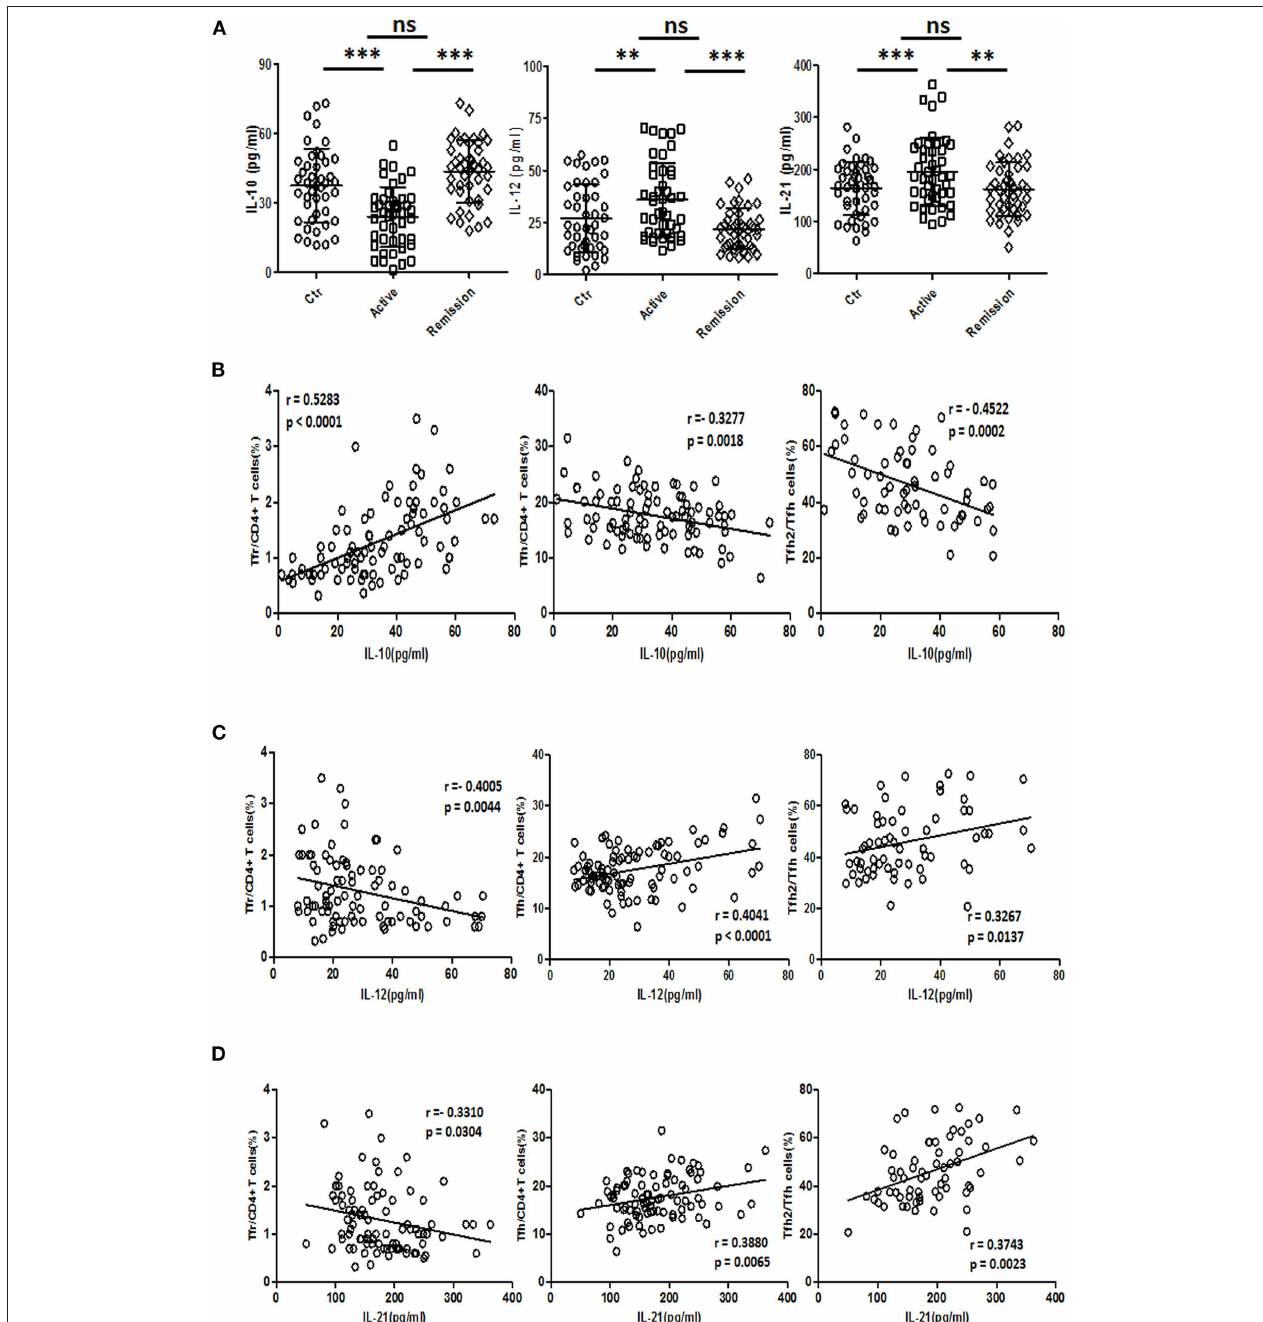
FIGURE 7 | Serum IL-10, IL-12, and IL-21 analysis and their relationship with TFR and TFH. (A) IL-10, IL-12, and IL-21 levels in serum of 44 healthy controls, 44 UC patients in active stage and 44 UC patients in stable remission were analyzed by ELISA. Their levels among three groups were compared. Symbols represent individual subjects and bars show the mean ± SD. ** p < 0.01; *** p < 0.001; ns, not significant. (B–D) Correlation analysis between serum IL-10, IL-12, IL-21 concentrations, and percentages of CXCR5 + FoxP3 + TFR cells, CXCR5 + FoxP3 − TFH cells was performed among 88 UC patients, including 44 active and 44 stable remission UC patients. Correlation analysis between cytokine levels and CXCR3 − CCR6 − TFH2 subsets was conducted in 64 UC patients (32 active and 32 stable remission UC patients). The r-values were the Spearman’s correlation coefficients, and p < 0.05 was linearly regressed to show relevant trends.